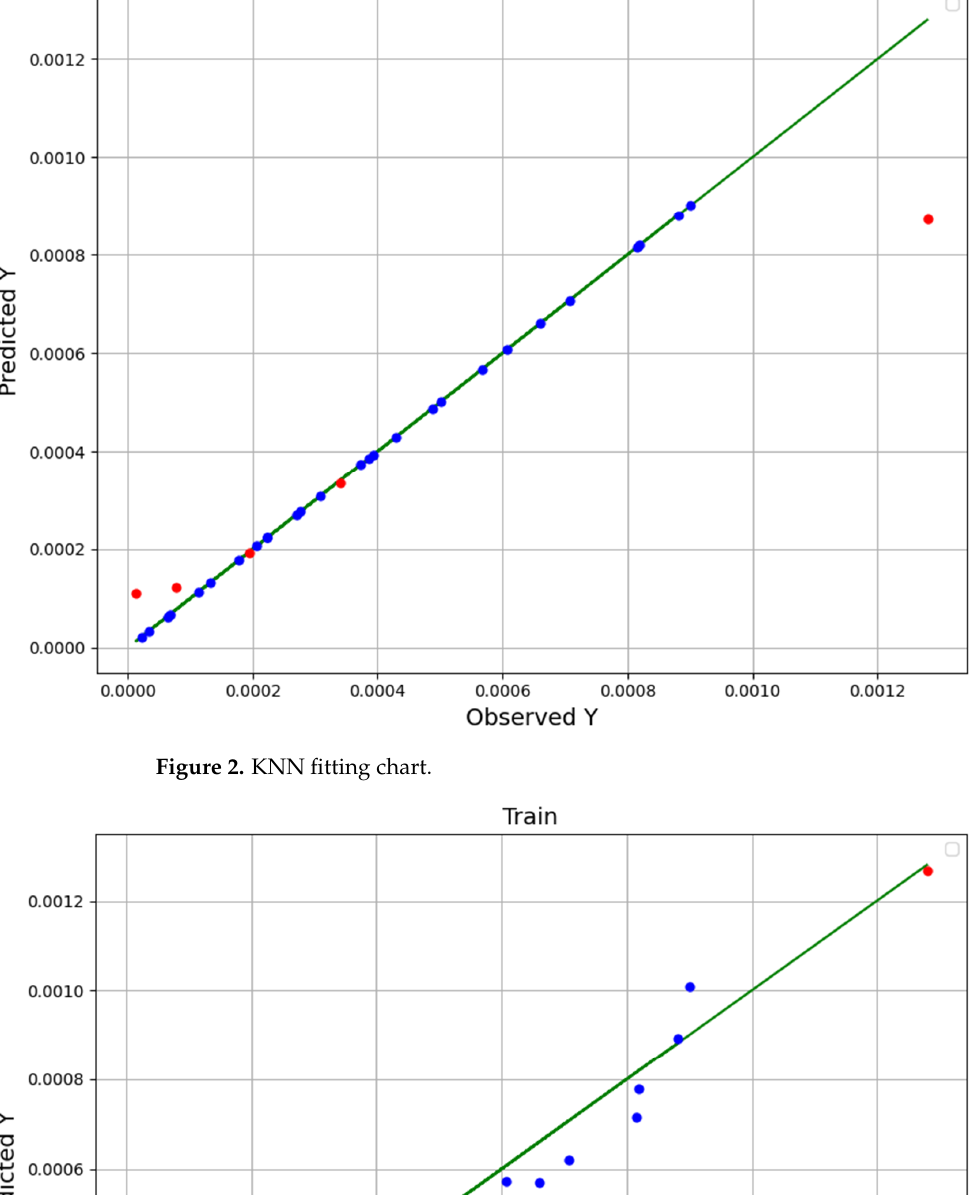
Figure 2. KNN fitting chart.